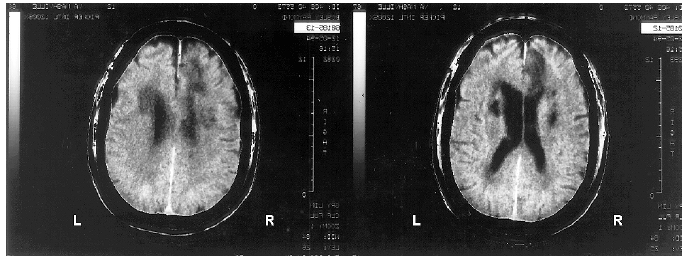
Fig. 3. CT scan, Patient 3, four days after admission, showing a right subcortical lesion involving the head of the caudate and anterior limb of internal capsule, a left subcortical lesion involving the head of the caudate, anterior limb, and anterior putamen, and a new lesion of the right medial frontal lobe. Note that right and left are reversed from the usual convention on this photograph, and the right side of the picture corresponds to the right side of the brain.